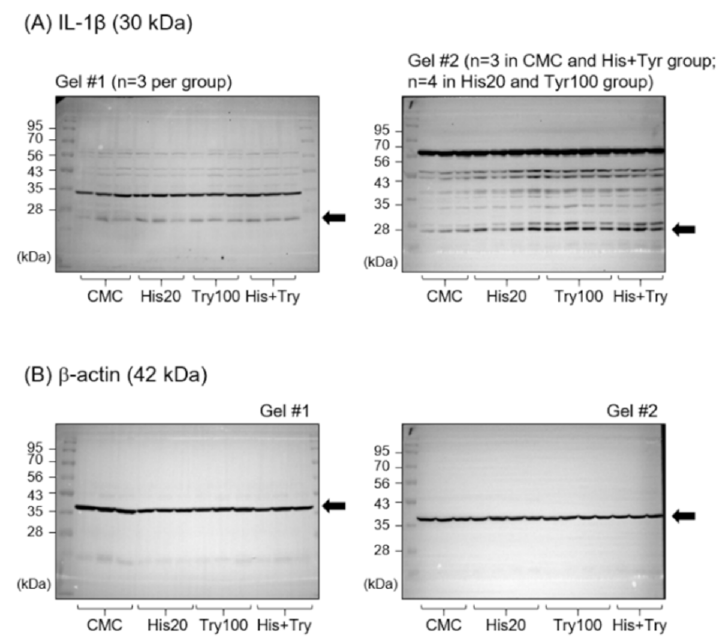
Figure A2. The full-length Western blot images corresponding to Figure 4B. ( A ) IL-1 β . ( B ) β -actin for IL-1 β . The arrows indicate the appropriate molecular weight of each protein.